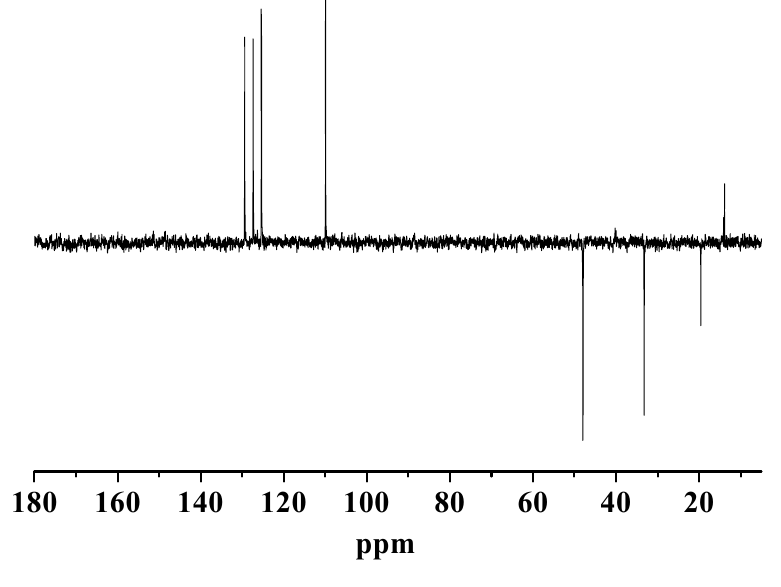
Figure 4. The proposed chemical structure of the compound BMI.